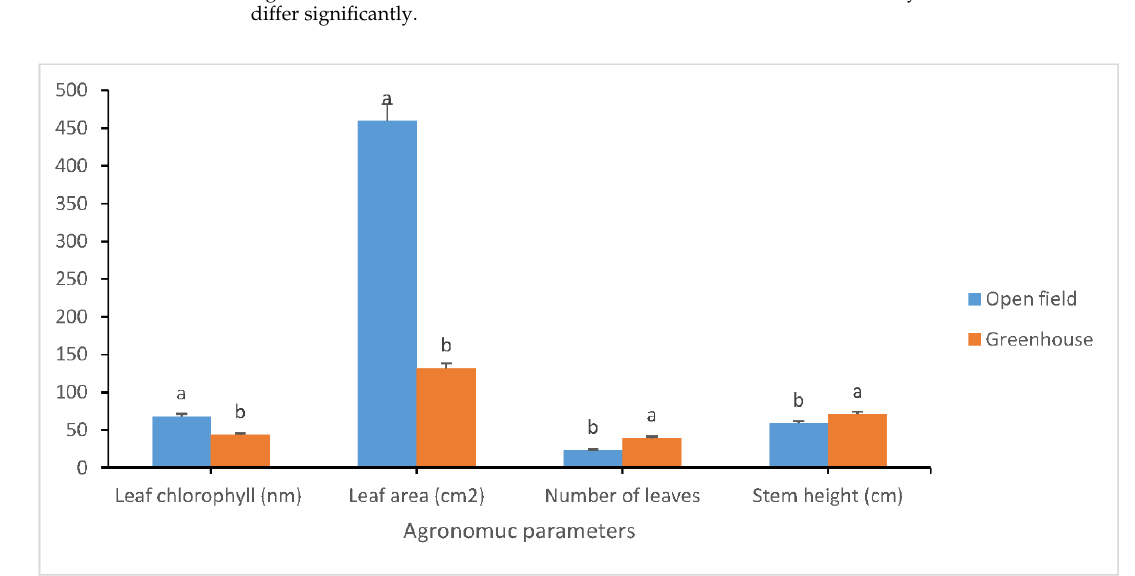
Figure 1. A comparative diagram showing the differences in growth parameters of A. Graecizans L. under open field (Blue) versus greenhouse (Orange) conditions, a referrer to open field whilst b referrers to greenhouse